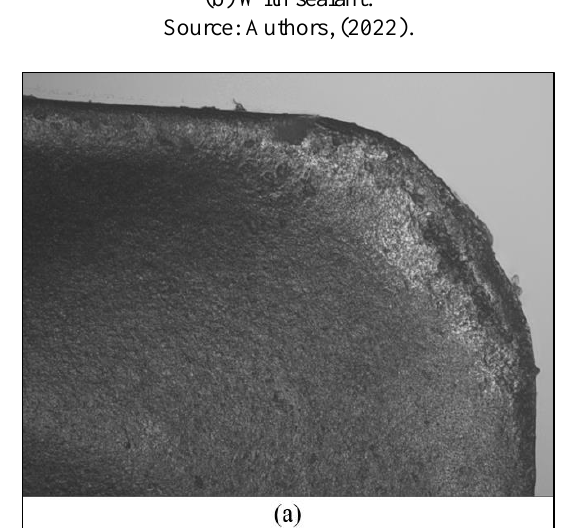
Figure 9a: Wear on the cutting tool rake surface with insert 0,8 mm: (a) Without sealant. Source: Authors,